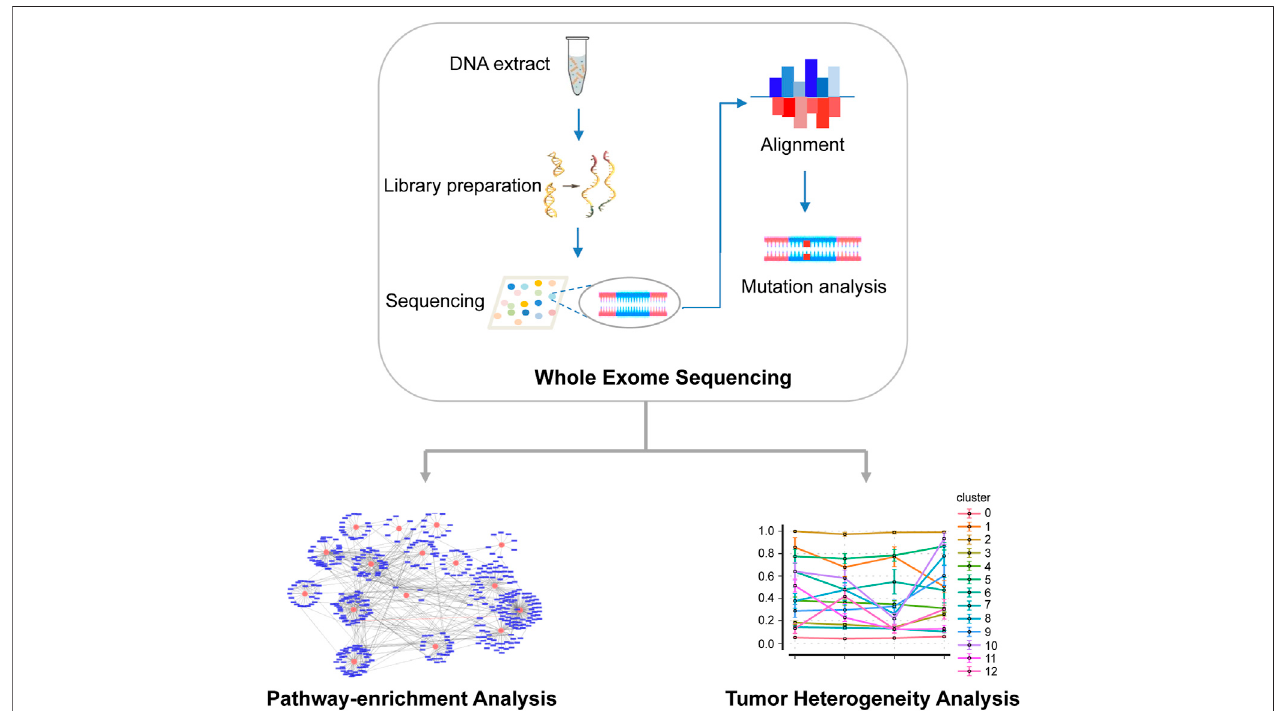
FIGURE 1 | Overview of the main work fl